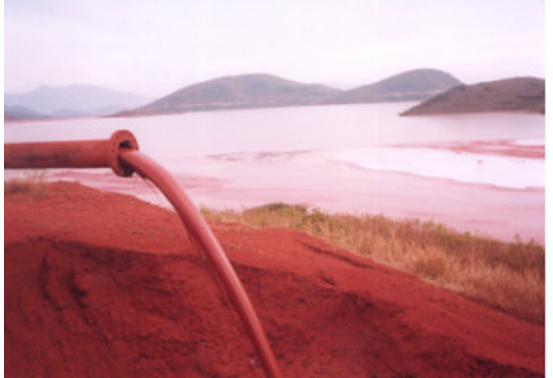
Figure 1. Discharge of red mud as slurry into the pond The geotechnical properties of red mud like specific